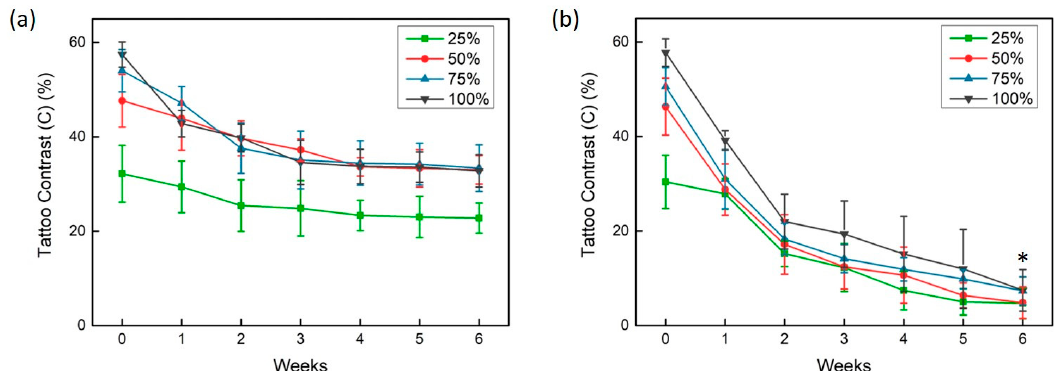
Figure 3. Variations in tattoo contrast as a function of time for four concentrations, namely: ( a ) control (non-treated) and ( b ) laser-treated tattoo samples (n = 5 per concentration; * p < 0.05 vs. week 0). Note that week 0 in ( b ) represents the tattoo contrast measured before laser treatment, and weeks 1–6 represents the contrast measured one week after each treatment.